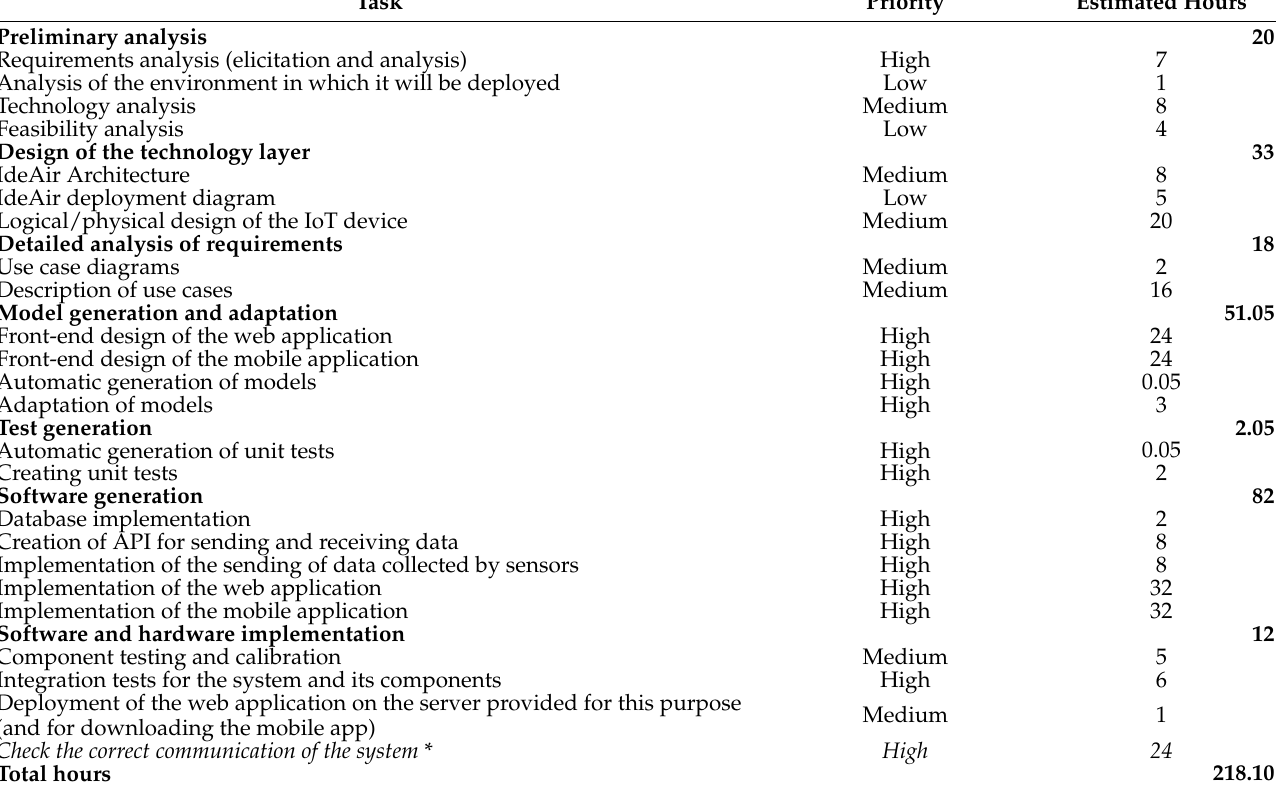
Table 2. Tasks to be carried out in the development of